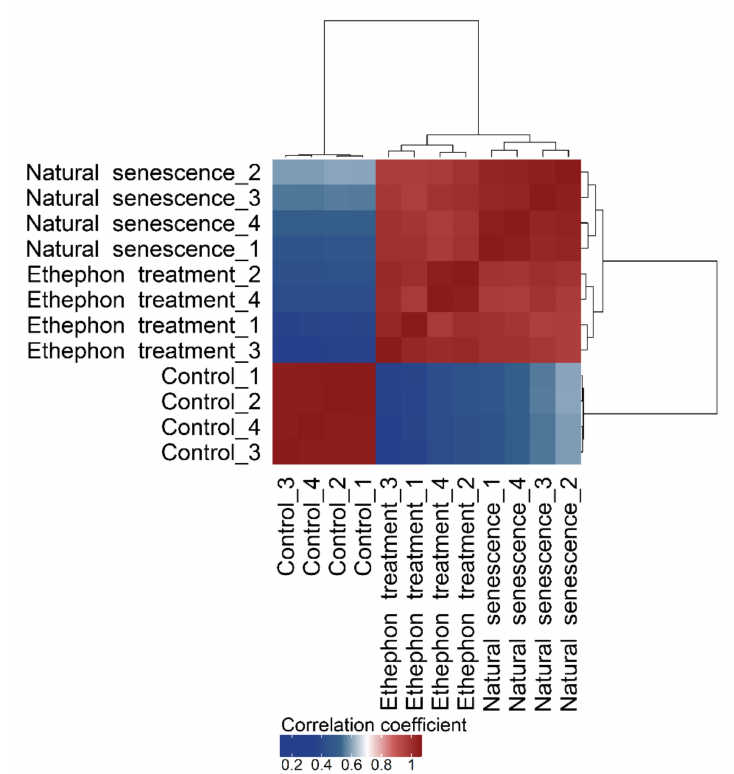
Figure 3. Hierarchically clustered correlation heatmap of control, ethephon treatment, and natural senescence sample transcriptomes. The color code shows Pearson’s correlation coefficient between the gene transcription profiles (normalized counts of 17,980 genes per sample) of all samples. The samples were clustered according to their Euclidean distances given by the